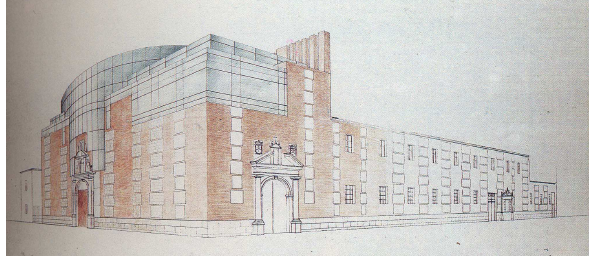
Figure 9. Proposal not built auditorium in the building